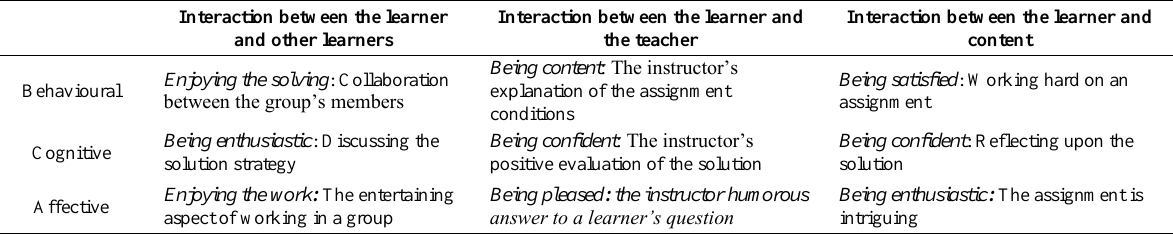
Table 6. Occurrences in the assignments that resulted in a positive affective engagement.